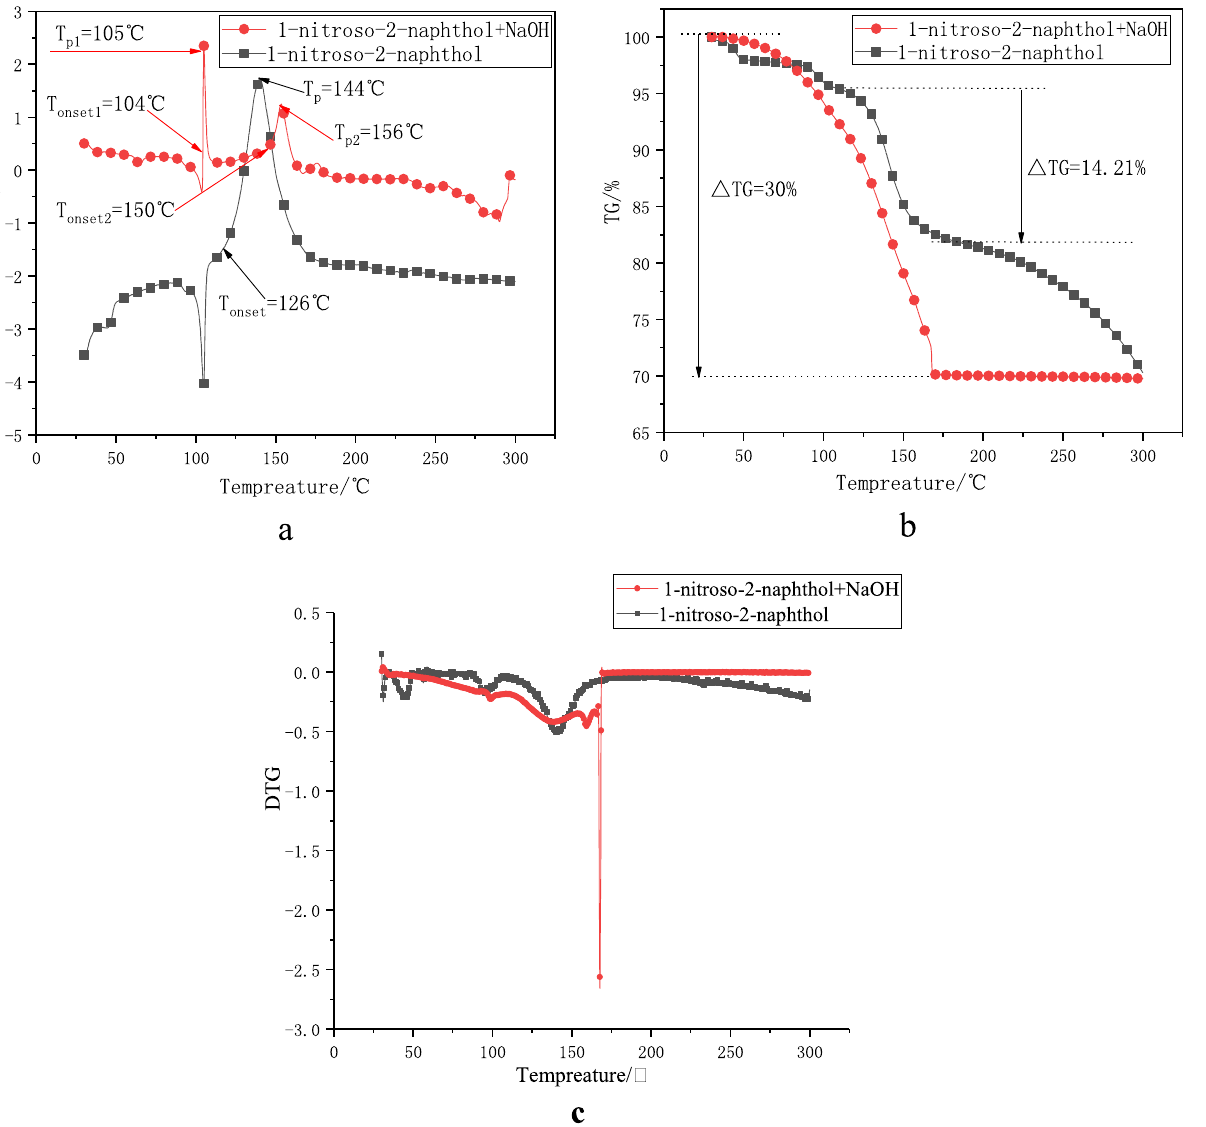
Figure 2. DSC curve ( a ) 、 TG curve ( b ) and DTG curve ( c ) of 1-nitroso-2-naphthol before and after adding sodium